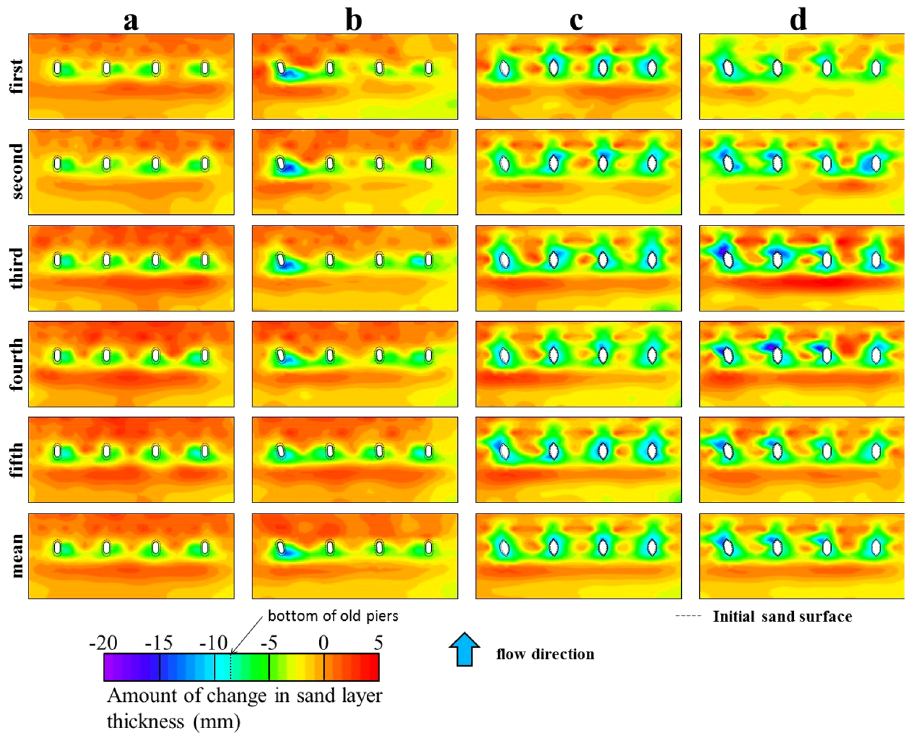
Figure 10. Changes in sand layer thickness after scouring around piers at end of experiment. ( a ) current; ( b ) current (skewed); ( c ) old (spindle type); ( d ) old (current